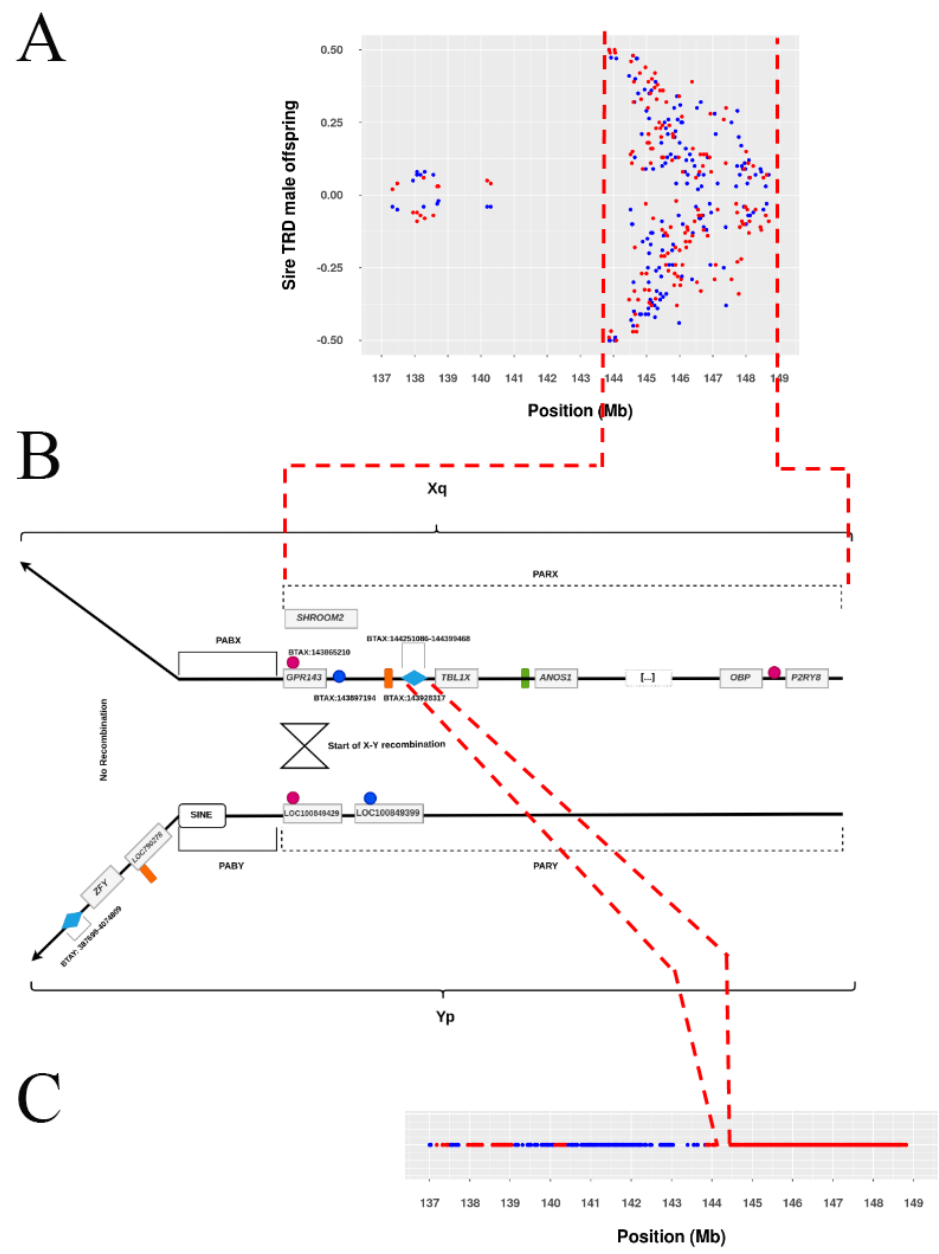
Figure 2. Schematic representation of the long arm of X-chromosome (Xq) and short arm of Y- chromosome (Yp) and sire-TRD patterns. ( A ) Magnitude of sire-TRD with opposite sign between male- (blue color) and female-offspring (red color) on pseudoautosomal SNPs. ( B ) Schematic repre- sentation of X and Y peudoautosomal regions (PARX and PARY) and peudoautosomal boundaires (PABX and PABY). ( C ) Density of SNP available for analyses (pseudoautosomal with red color and heterosomal with blue color). The pink and blue circles represent the first two markers with α = 0.5 (BTX:143,865,210 and BTX:143,870,595), respectively. The red circle represents the last marker with an opposite sire-TRD effect between male and female offspring (BTX:148,789,832). The orange and green rectangles correspond to the markers with opposite sire-TRD effects between male and female offspring and dam-TRD for male (orange) and female (green) offspring. The blue diamonds represent the region with highest homology between the X- and Y-chromosomes (BTX:144,251,086–144,399,458). It is important to highlight that this is a schematic image and some genes where sup- pressed.